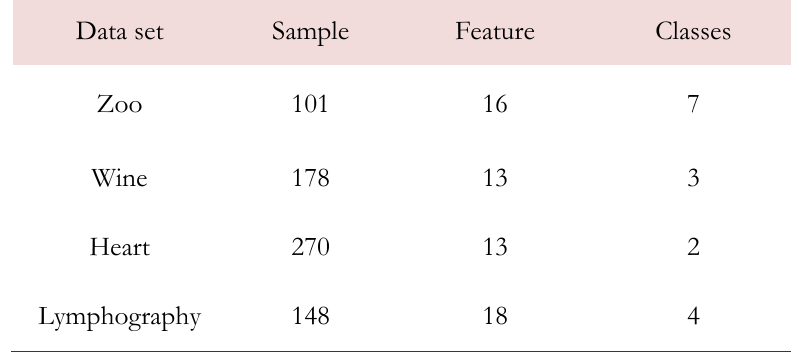
Table 3: Information of the data set